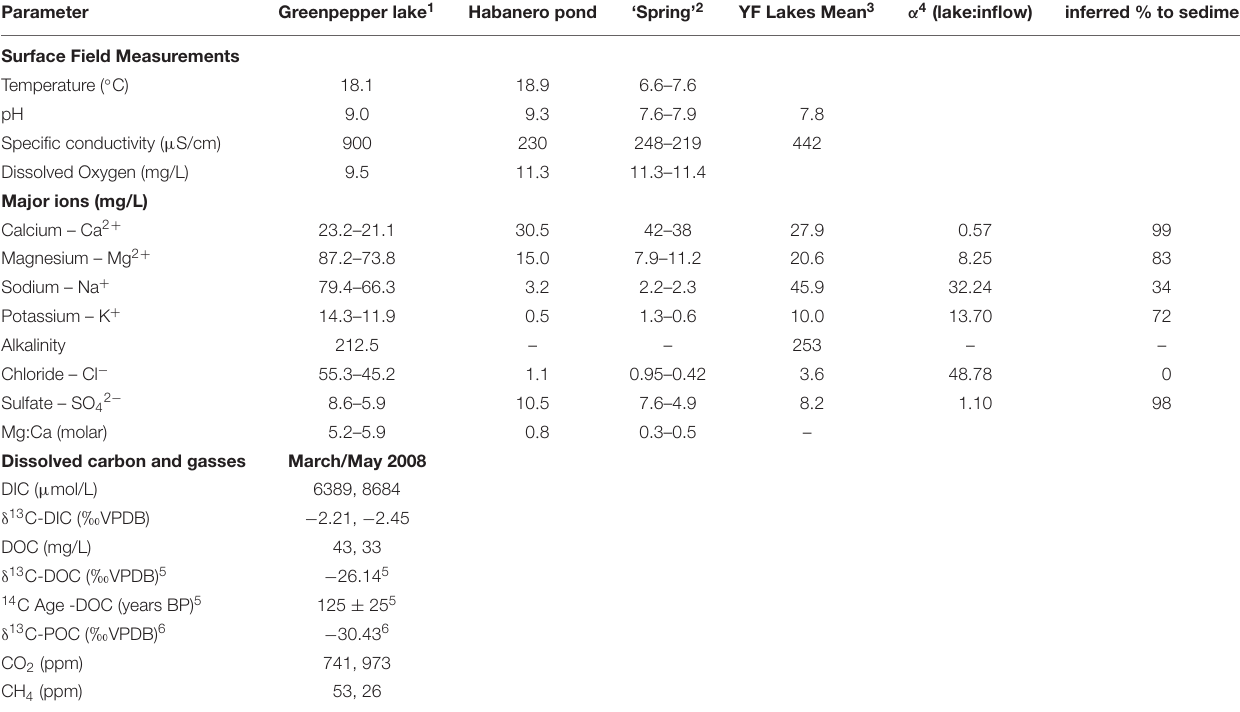
TABLE 2 | Aqueous geochemistry of Greenpepper